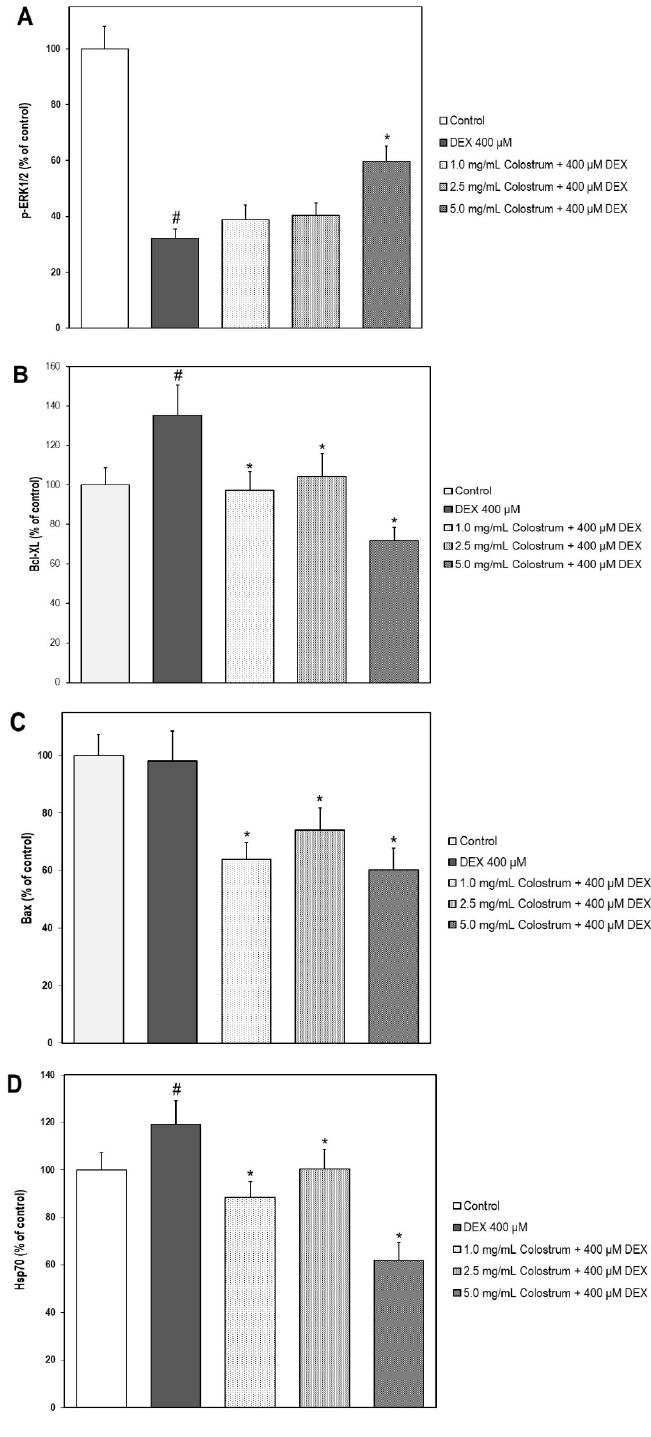
Figure 10. Effect of colostrum treatment on p-ERK1/2, Bcl-XL, Bax, and Hsp70 protein levels on DEX-treated MC3T3-E1 cells. Phospho-ERK1/2, Bcl-XL, Bax and Hsp70 protein levels were detected by Western blot analysis. The levels of the p-ERK1/2 ( A ), Bcl-XL ( B ), Bax ( C ), and Hsp70 ( D ) were represented as relative percentages of the control after its normalization by the β -actin. The data are expressed as the mean ± S.E.M. of three independent experiments. * Significant differences of colostrum plus 400 µ M DEX versus 400 µ M DEX-treated cells (Newman–Keuls test, * p < 0.05). # Significant differences of 400 µ M DEX-treated cells versus control cells (Newman–Keuls test, # p <